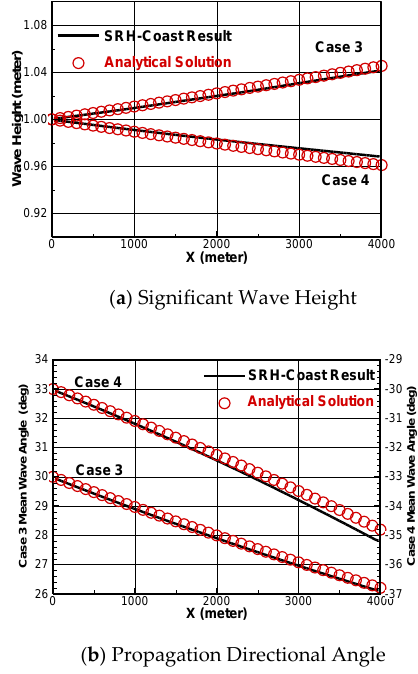
Figure 6. Predicted significant wave height and wave angle in comparison with the analytical solution for cases 3 and 4.